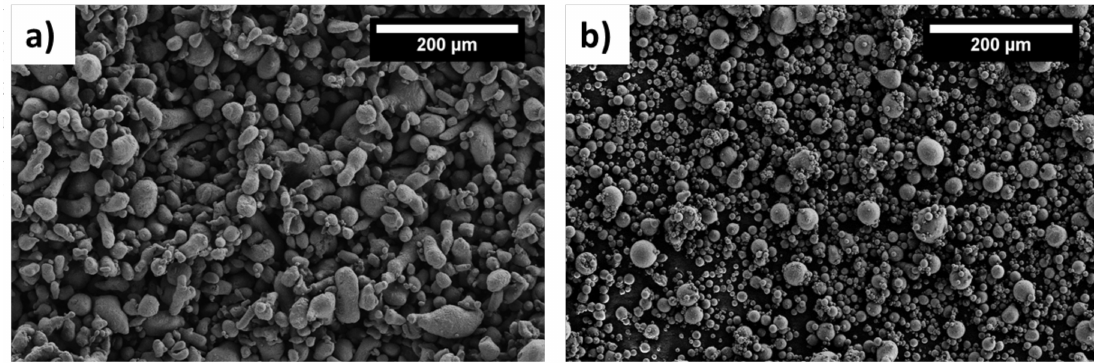
Figure 1. Field Emission Scanning Electron Microscopy (FE-SEM) micrographs of ( a ) 7075 and ( b ) AlSi10Mg powders.